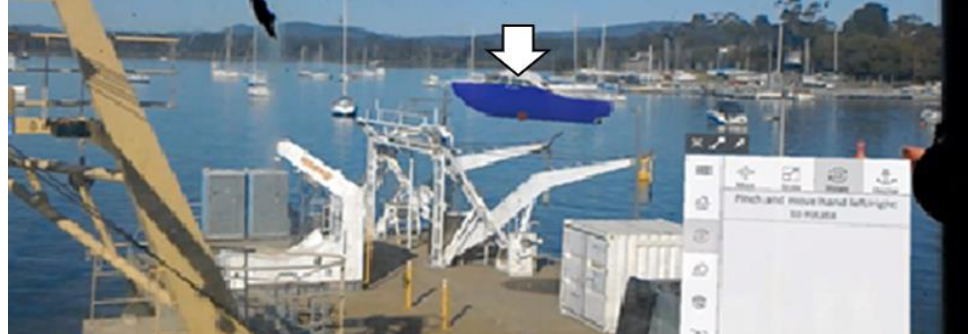
Figure 2. Projected view of fishing boat at AMC Surface Vessel Bluefin at angle of 115.4°. J. Mar. Sci. Eng. 2020 , 8 , x FOR PEER REVIEW